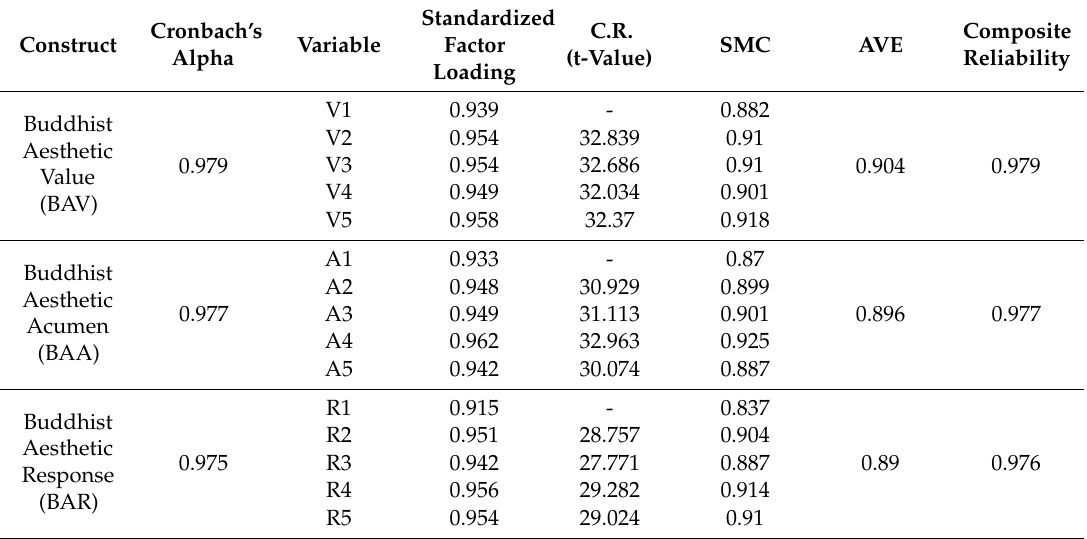
Table 5. Convergent and discriminant validity of the Buddhist aesthetics scale.